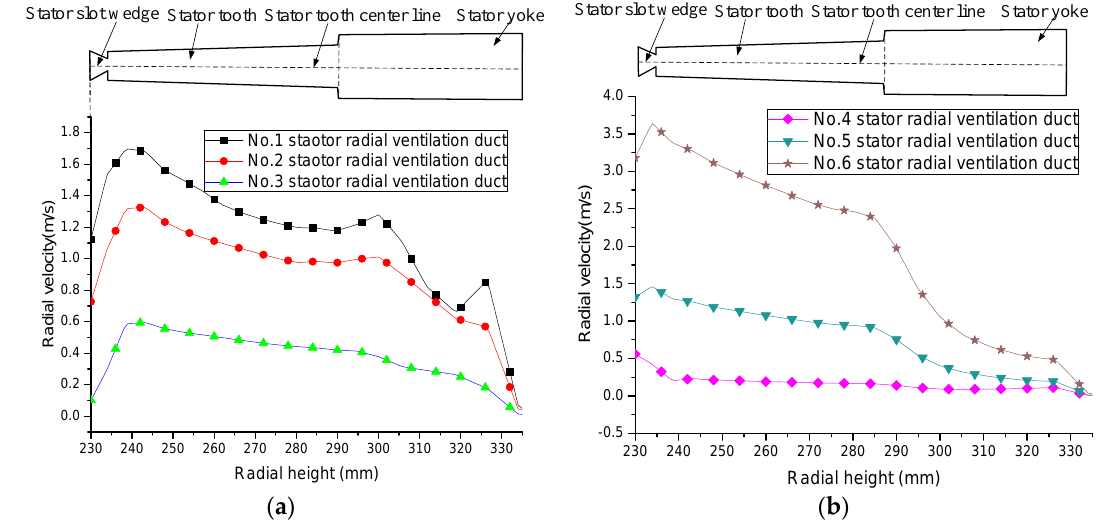
Figure 12. The changing trend of the radial flowing velocity of fluid of HVLSSR-PMSM with dual ventilation path: ( a ) No. 1, No. 2, No. 3 stator radial ventilation duct; ( b ) No. 4, No. 5, No. 6 stator radial ventilation duct.